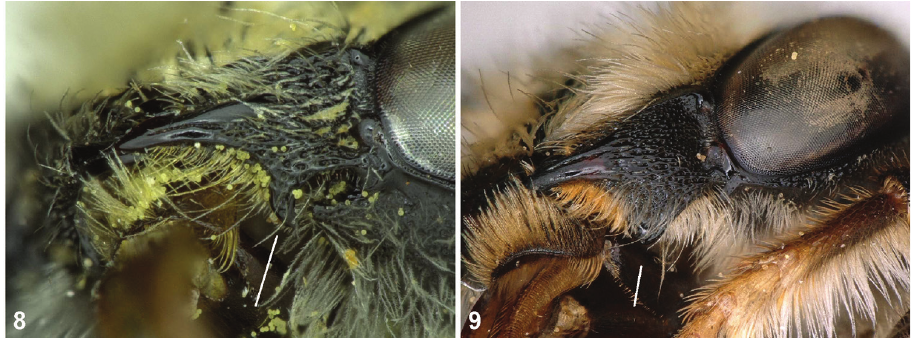
Figure 8–9. Inferior projection of male mandible. 8 Megachile ( Eutricharaea ) leachella , inferior projec- tion pointed and projecting posteriorly 9 M. ( Creightonella ) albisecta , inferior projection rounded and directed